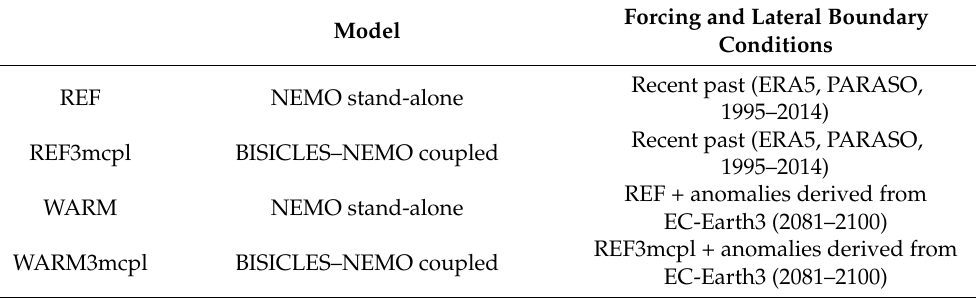
Table 1. Names and descriptions of the simulations used in this